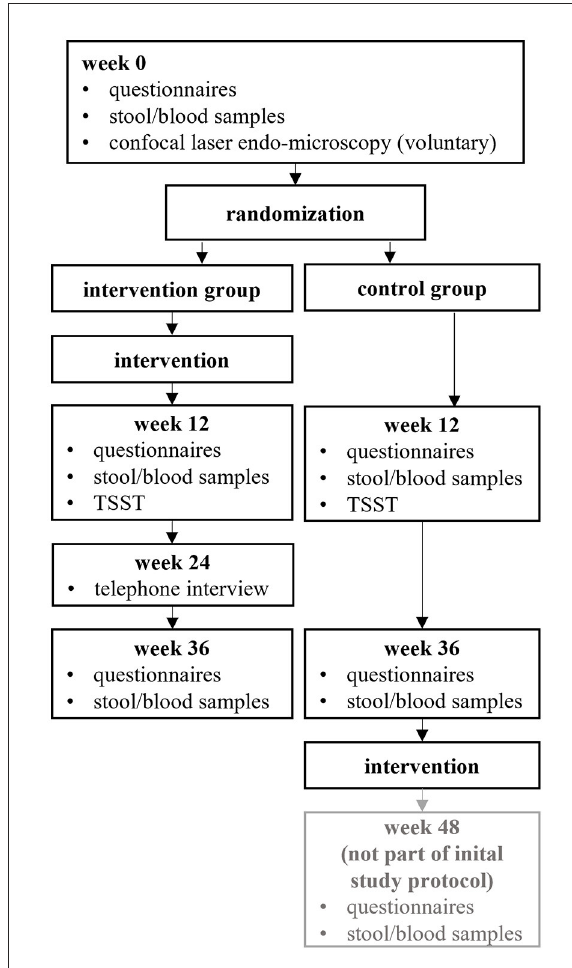
FIGURE1 Illustration of the study design. TSST, Trier Social Stress Test.